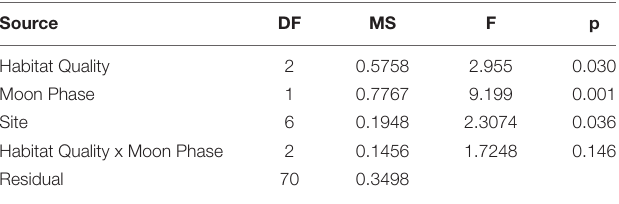
TABLE 1 | PERMANOVA results testing the effects of habitat quality, moon phase, and site on larval community